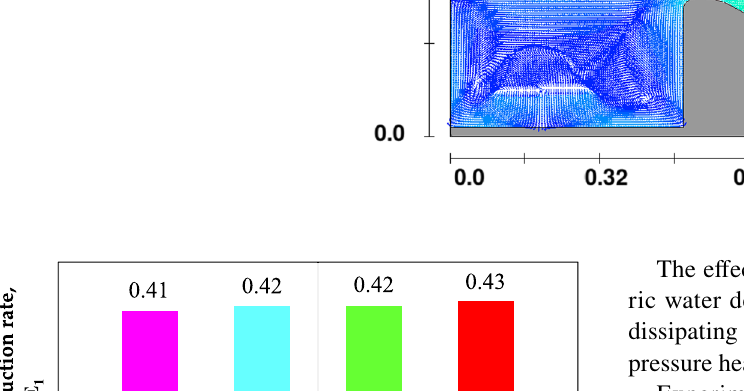
Fig. 18 Maximum and mini- mum velocity values and veloc- ity paths around the obstacles